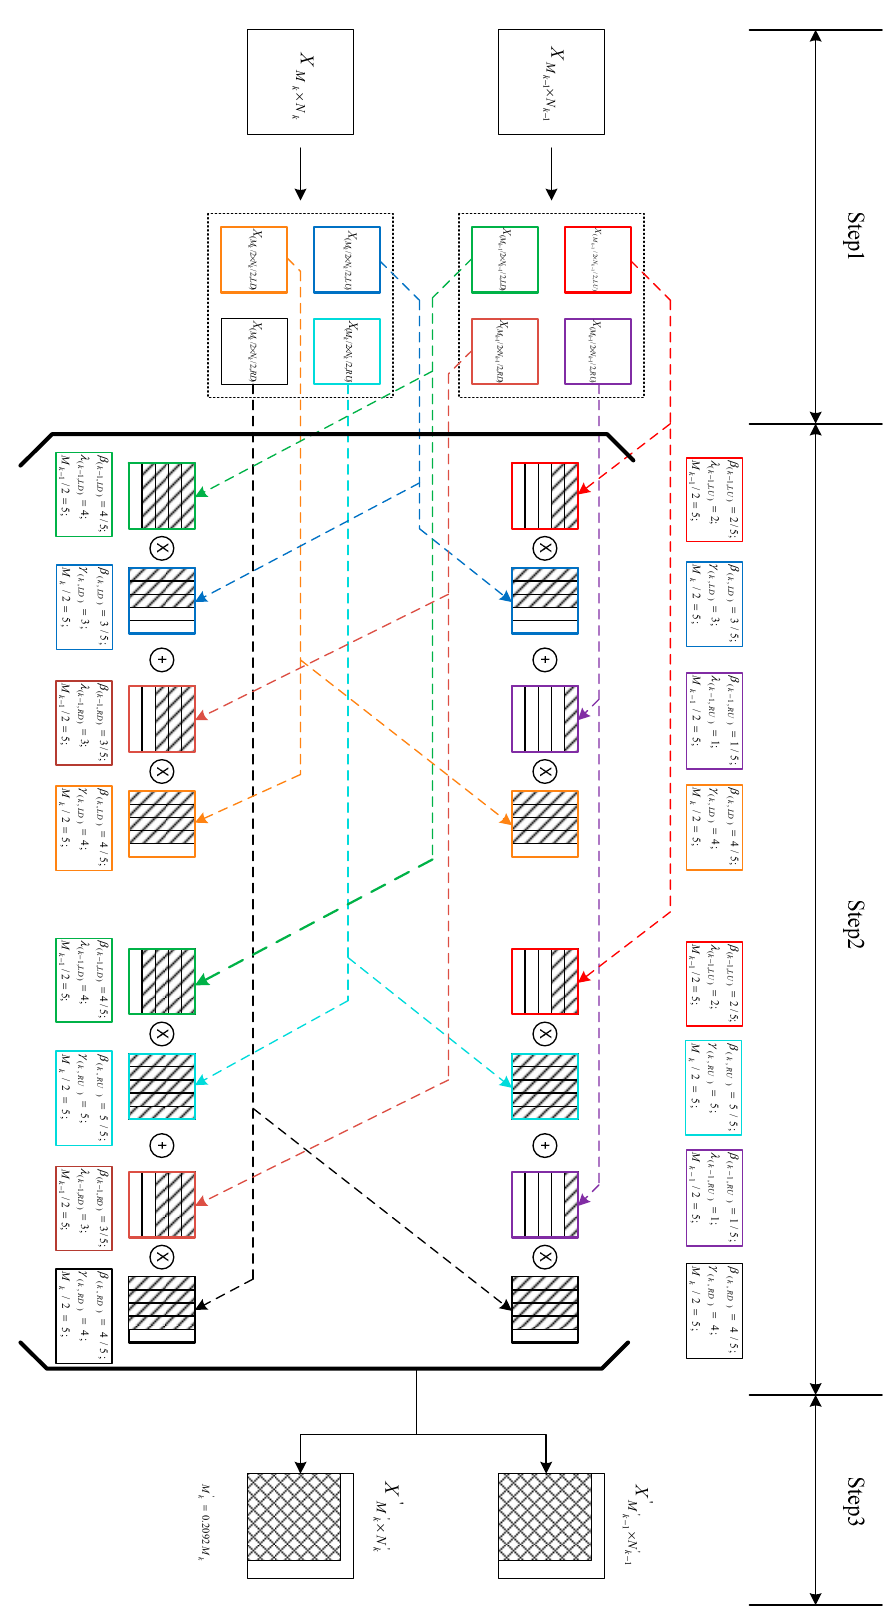
Figure 1. Equivalent reduced-order calculation based on sparse features of block matrix.